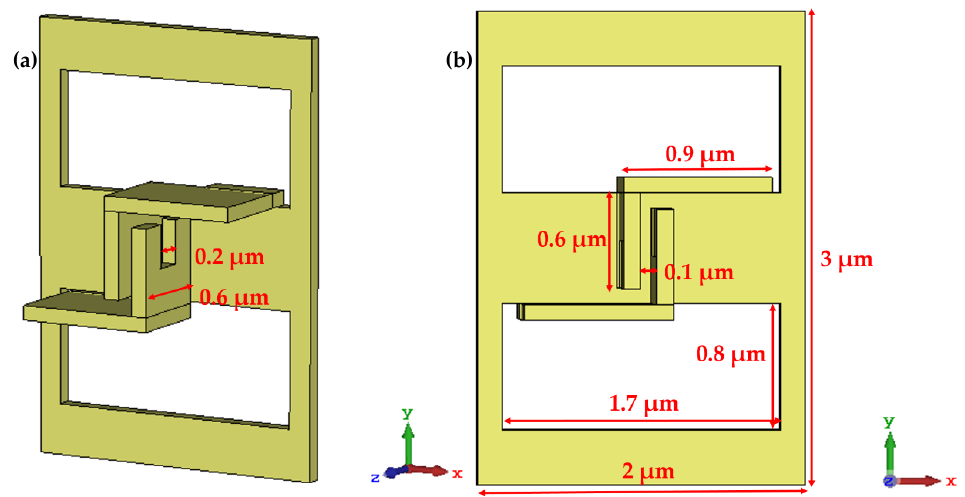
Figure 1. The designed structure of 3D meta-atom. ( a ) Oblique and ( b ) overhead views of a 3D meta-atom unit cell, which contains a pair of coupled claws with a gap of 0.1 µ m, a length of 0.9 µ m and a height of 0.6 µ m. The whole array is 90 µ m by 60 µ m with a period of 3 µ m in Y-axis direction and 2 µ m in X-axis